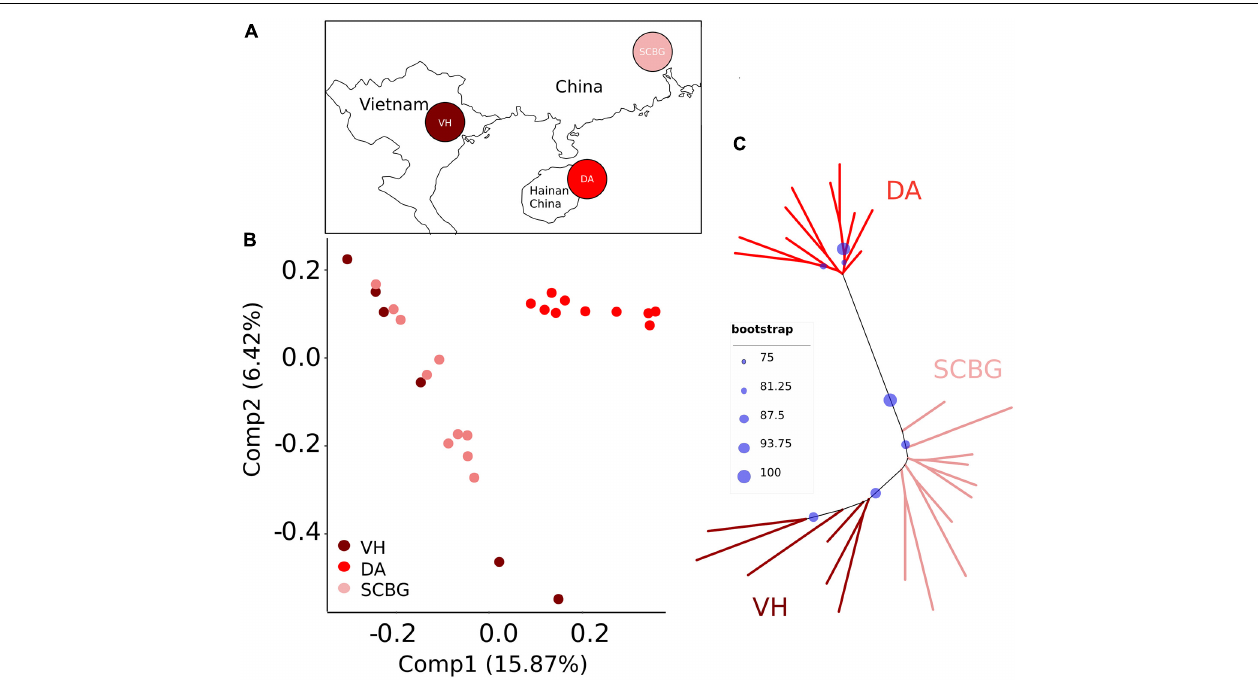
FIGURE 1 | (A) Sampling locations. Sampling sites are Vinh Yen, Vietnam (VH, dark red); Hainan Island, China (DA, red); and Guangzhou, China (SCBG, pink). The map is constructed by R package maps 3.3.0 (Becker et al., 2018). (B) Principal component analyses (PCA) based on SNPs for populations. (C) Maximum likelihood (ML) tree based on SNPs. The bootstraps are indicated with blue spots. Population codes and color scheme for genetic groups is the same in (A–C) . TABLE 1 | Sample list and statistic of variants. Sampling